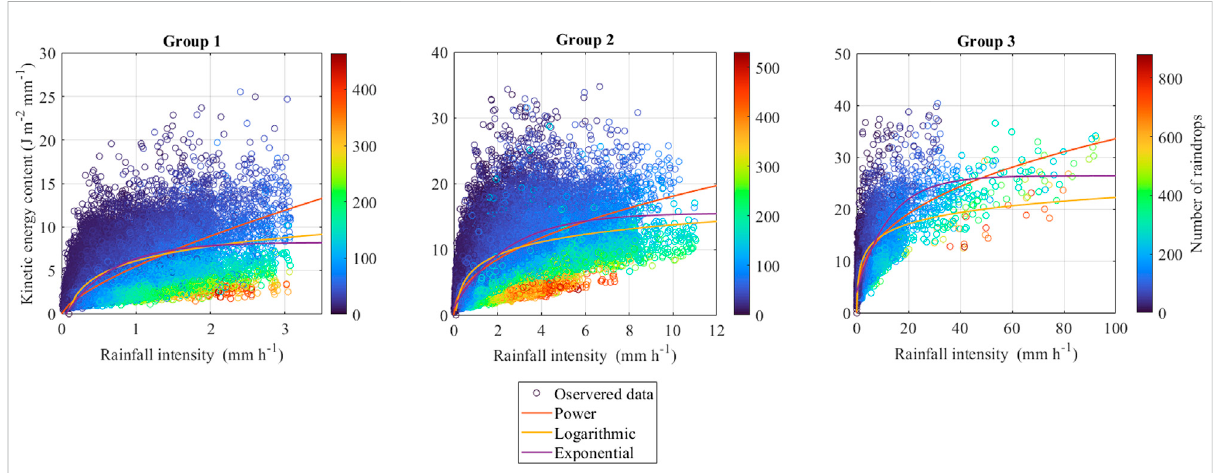
FIGURE 7 Scatter plots of KE con – I r points, which were analyzed and described by different equations corresponding to each rainfall event group.